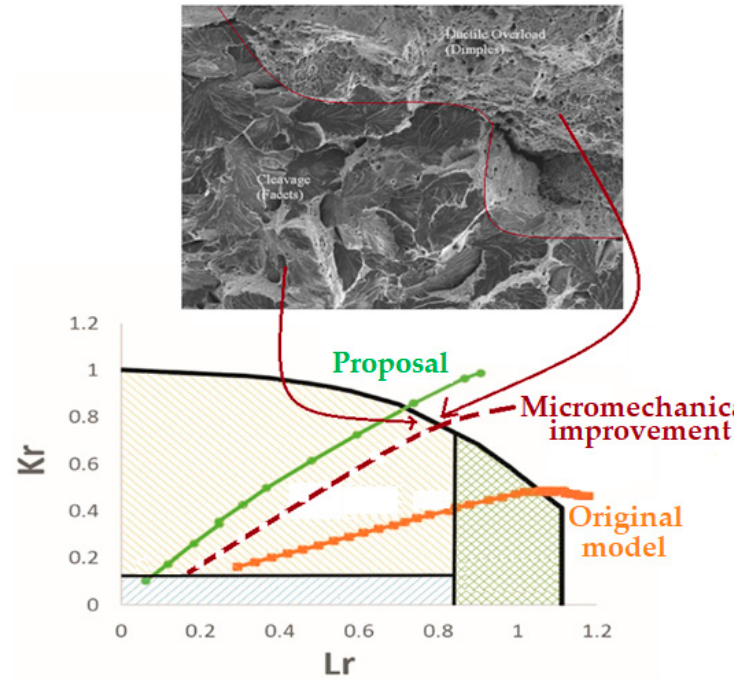
Figure 22. Improvement proposal for possible future work based on the work presented.